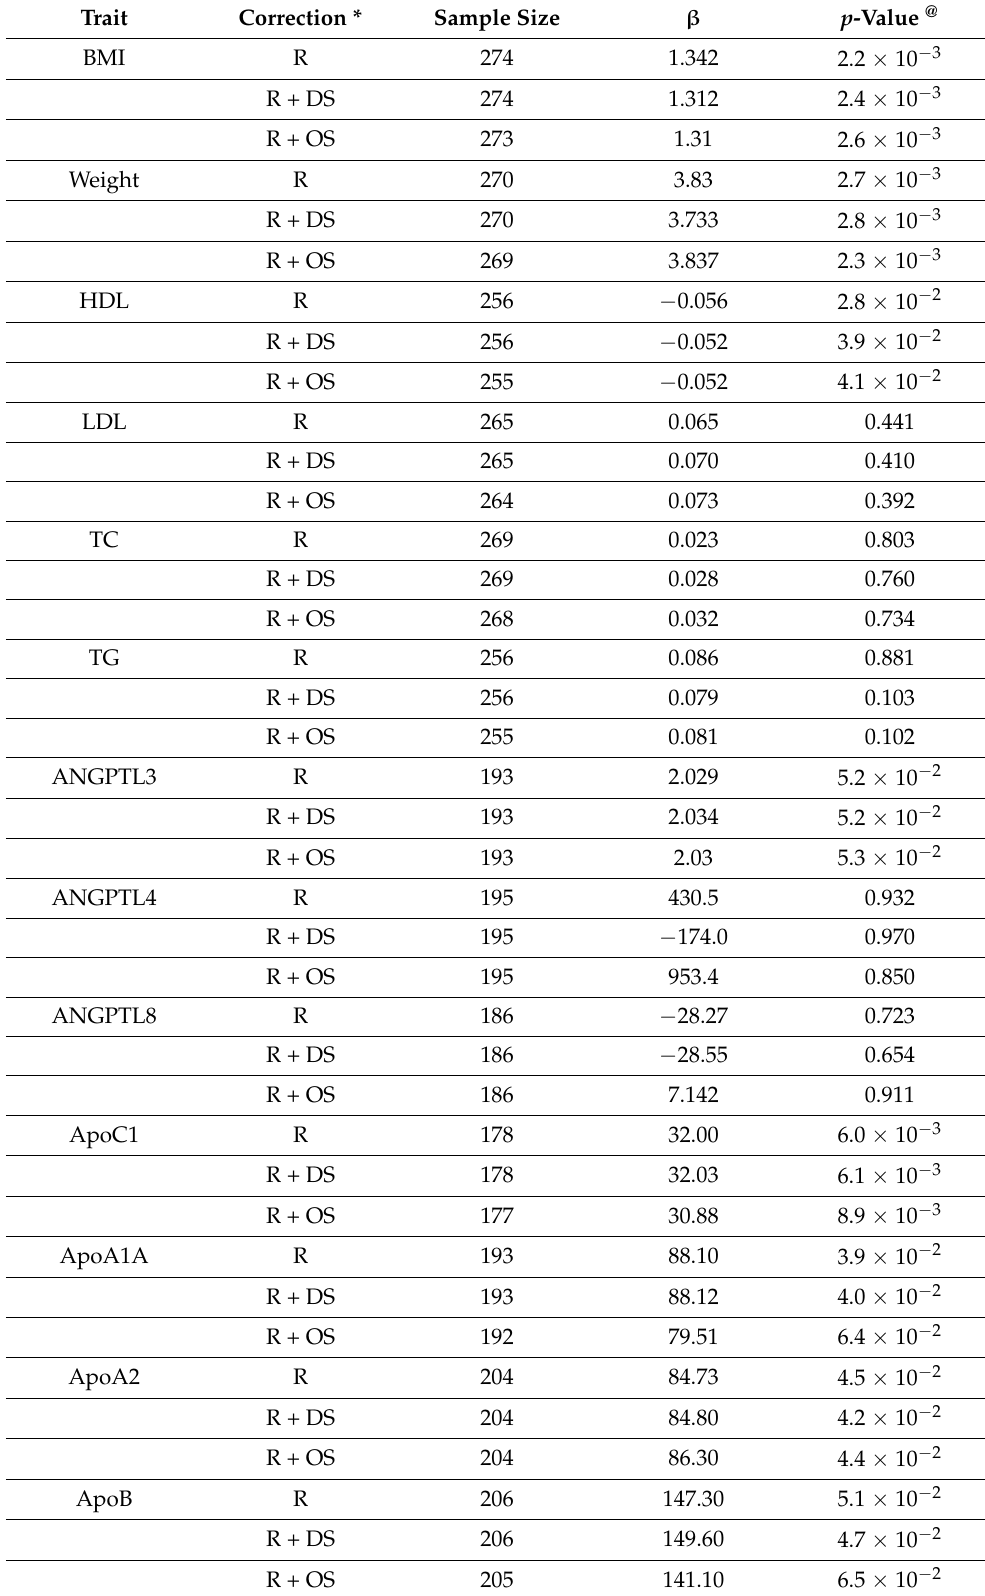
Table 3. Results of association tests for the study variant with G as effect allele with the quantitative traits and biomarkers, using genetic model based on additive mode of